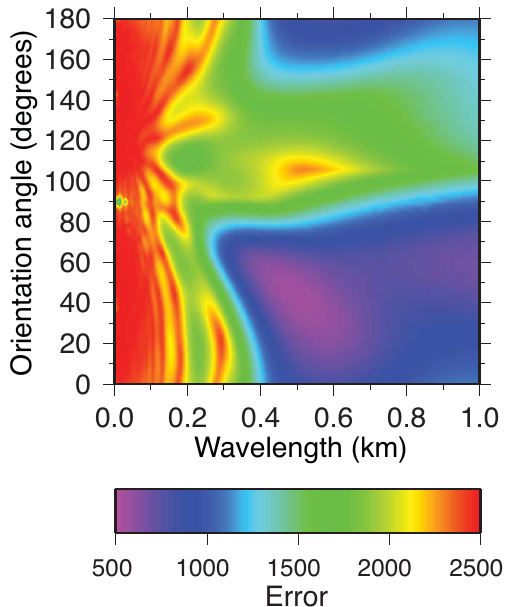
Fig. 9. Error (sum of squared differences) surface as a function of wavelength and orientation angle (defined as in Fig. 7) for sinu- soidal surface fitting of the reflection portion shown in Fig. 8.